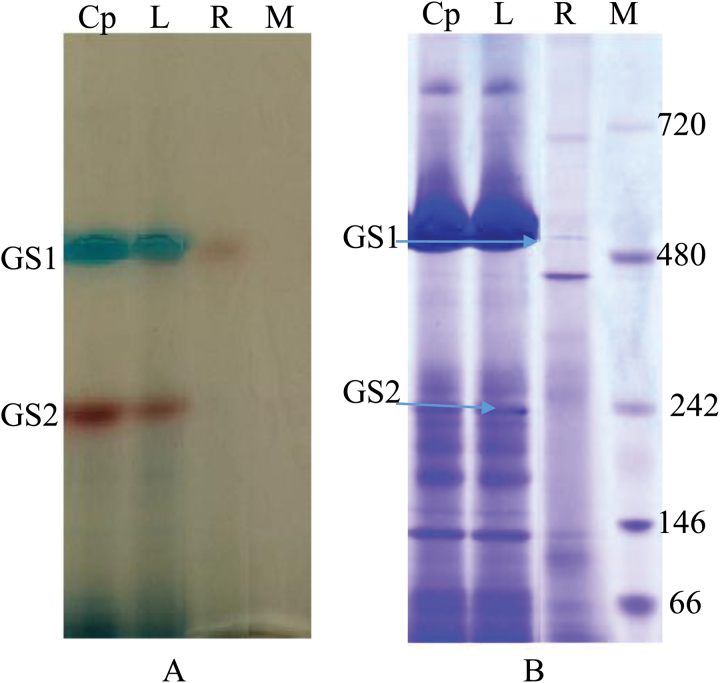
Identification of the native molecular weight of GS isoforms using BNE. (A) Soluble proteins (~100 μg) from wheat seedling chloroplasts (Cp), leafs (L), and roots (R) were separated by BNE on a 4–13% polyacrylamide gradient gel, and GS isoforms were detected with a transferase activity assay. (B) The GS bands were marked and the gel stained with Coomassie Blue R250. M, high-molecular-weight markers (mass in kDa given to the right of the gel). (This figure is available in colour at JXB online.)